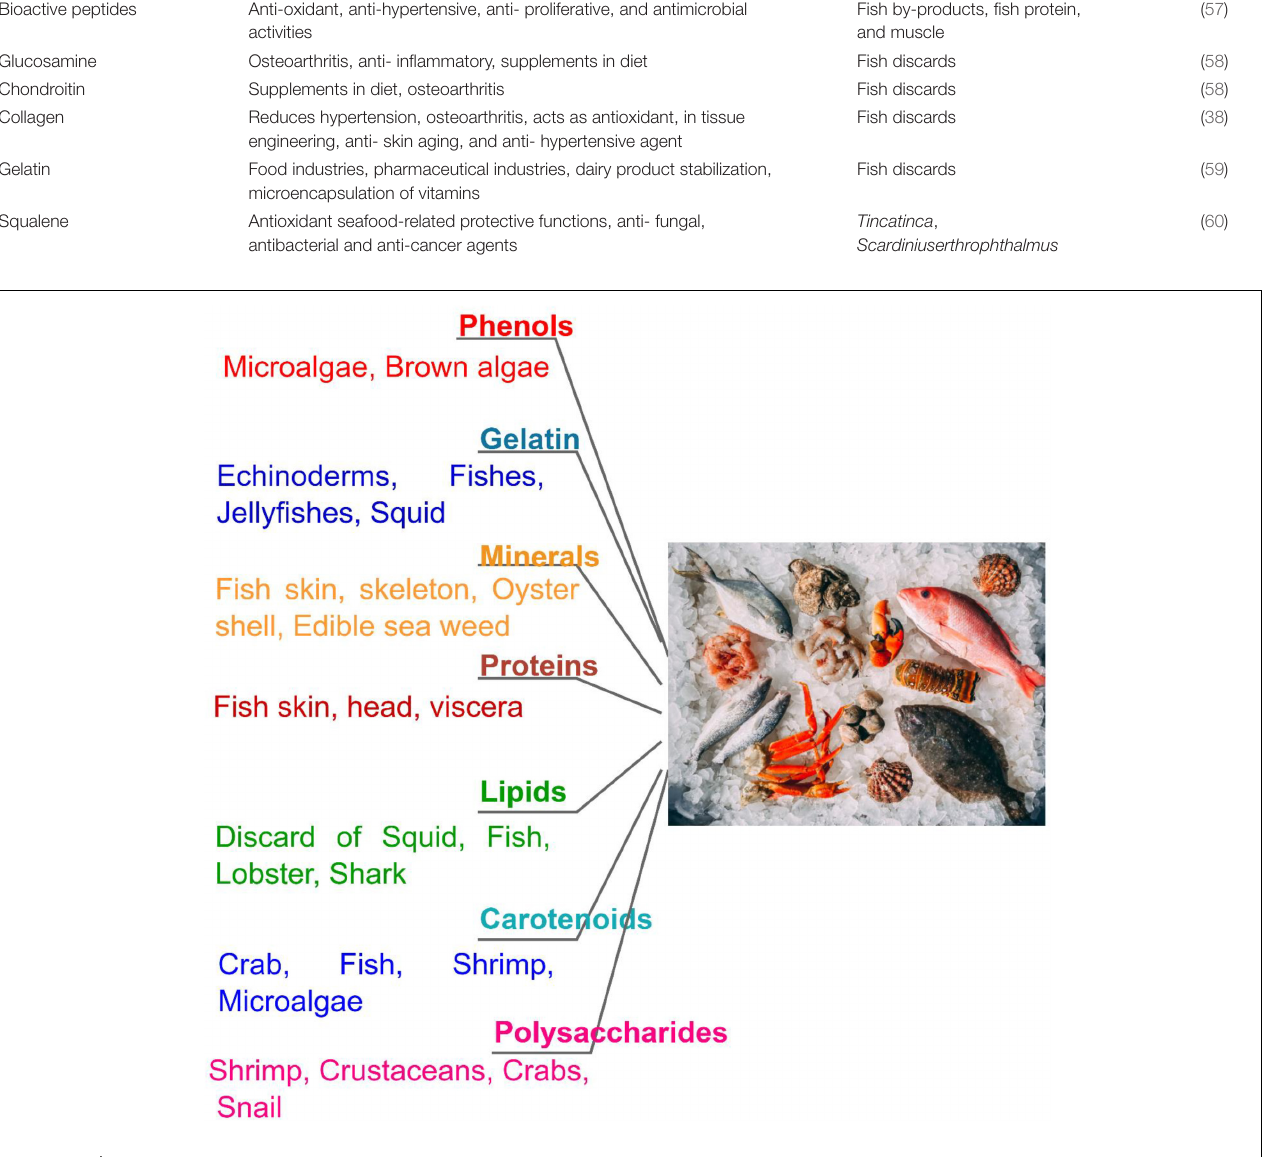
FIGURE 2 | Biomacromolecules from seafood